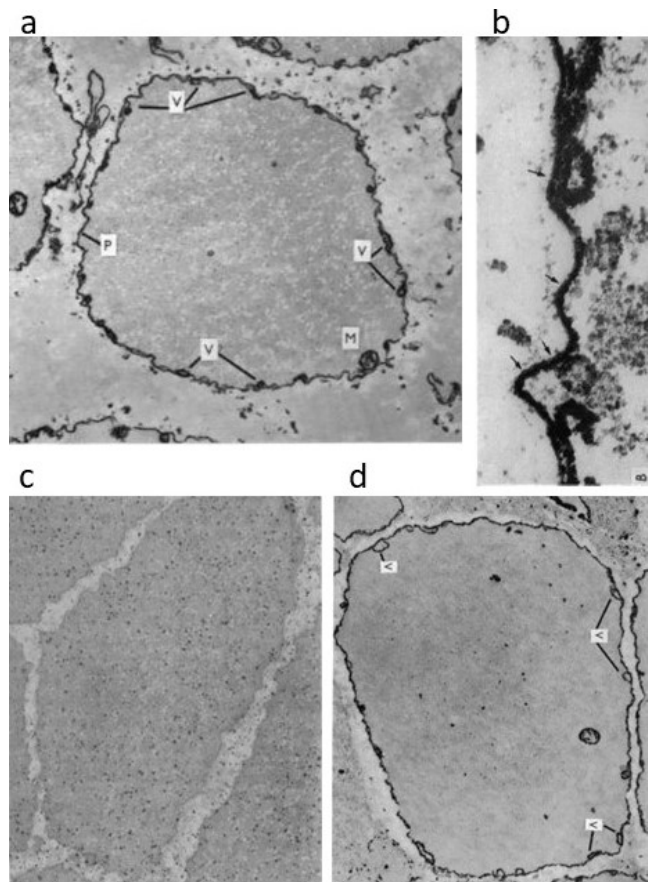
Figure 6. Intracellular localization and translocation of Ca-containing electron-opaque pyroantimonate precipitate in the ABRM fibers. ( a ) Cross-section of resting fibers exhibiting electron-opaque precipitate along the inner surface of the cell membrane (P), at the intracellular vesicles in close apposition to the cell membrane (V), and at the mitochondria (M). ( b ) High magnification view around the cell membrane. Arrows indicate outer surface of the cell membrane. ( c ) Cross-section of actively contracted fibers. Note the diffuse distribution of pyroantimonate precipitates in the cytoplasm in the form of fine particles. ( d ) Cross-sections of fibers in the catch state. Note that pyroantimonate precipitate shows localization similar to that in resting fibers. Calibration, 1 µm for ( a ), ( c ) and ( d ), and 0.1 µm for ( b ). (Atsumi and Sugi [28]).